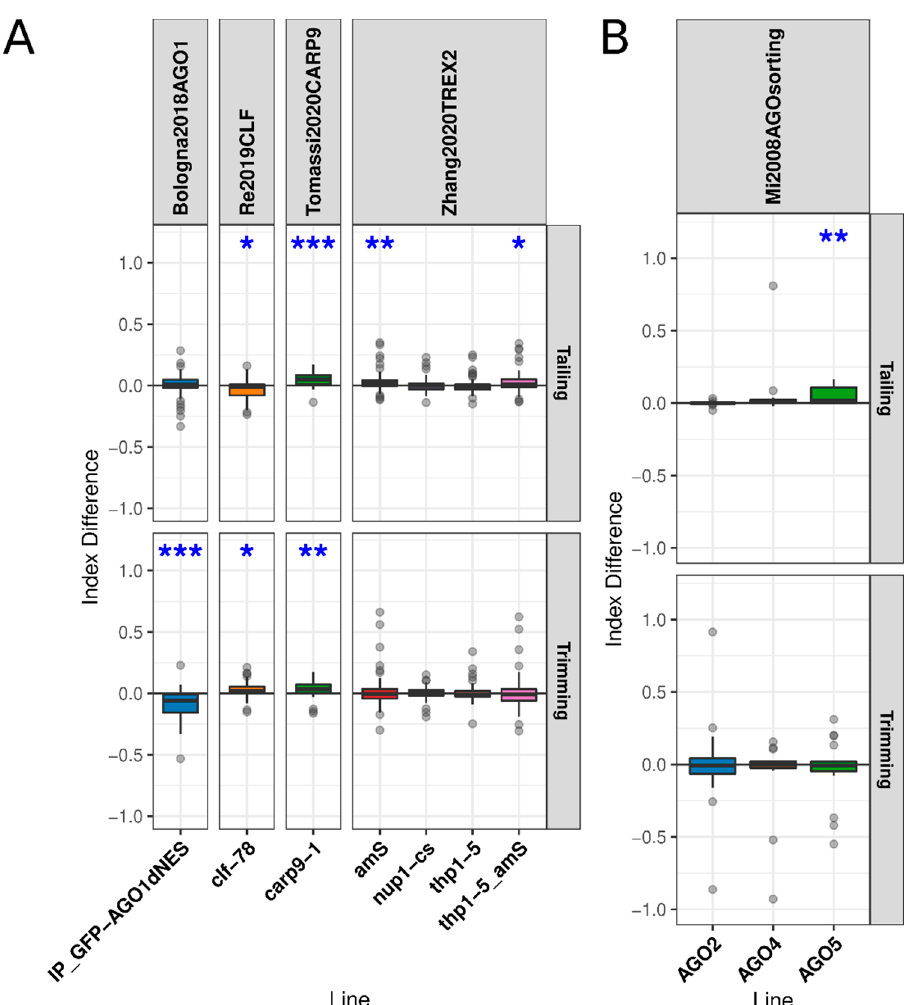
Figure 4. AGO1 homeostasis and the contrast with different AGO proteins: ( A ) distribution of guide miRNA IDs in mutants related to genes related to AGO1 nuclear homeostasis, loading, and miRNA export and ( B ) distribution of guide miRNA IDs in IPs of different AGO proteins using AGO1 IP as a reference, where the asterisks over the boxplots indicate the results of paired t-tests between the mean index of the line and that of the reference line, paired by miRNA. * p -value below 0.05, ** p -value below 0.01, and *** p -value below 0.001. The tests were grouped by the modification evaluated, trimming or tailing, and p -values were FDR-corrected across all studies analyzed in this work.